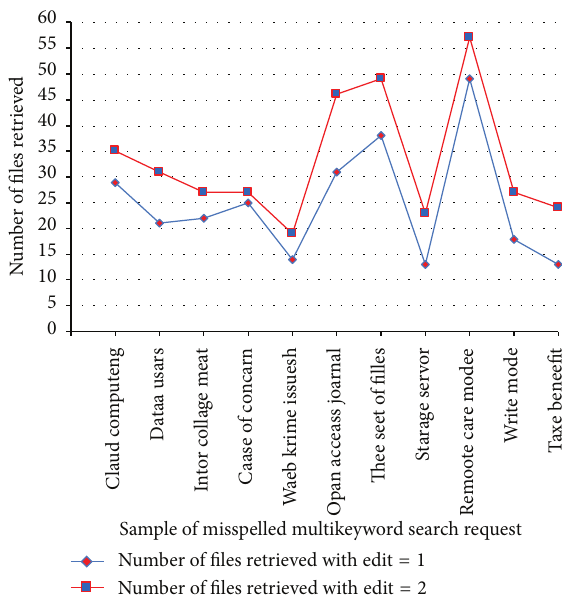
Figure 5: Data utilization efficiency for misspelled keywords in ACMFS.